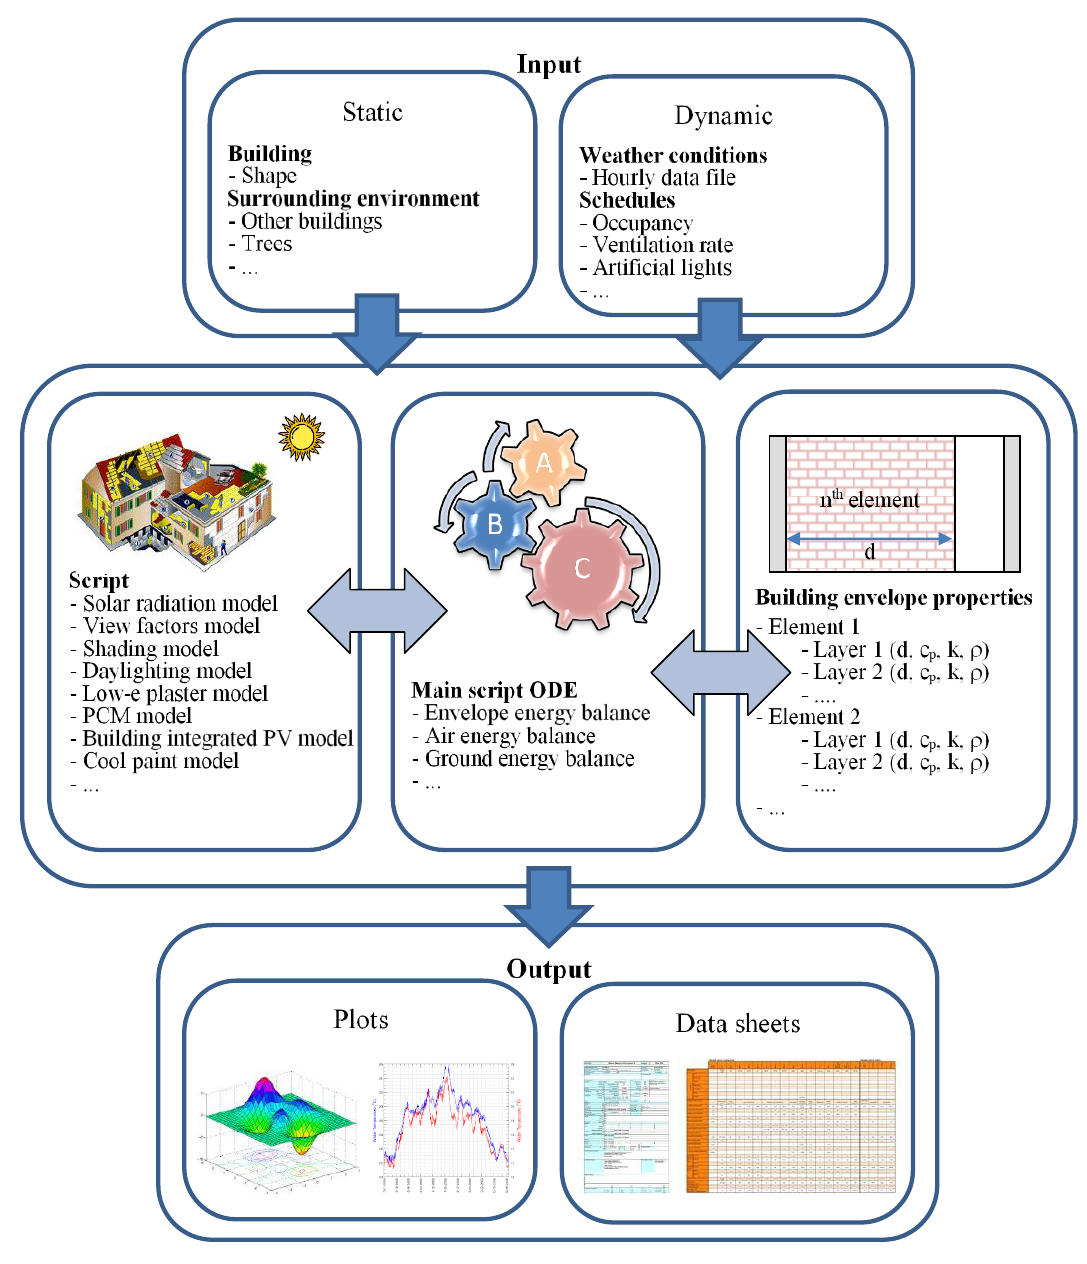
Figure 1. Simulator scheme and concept.